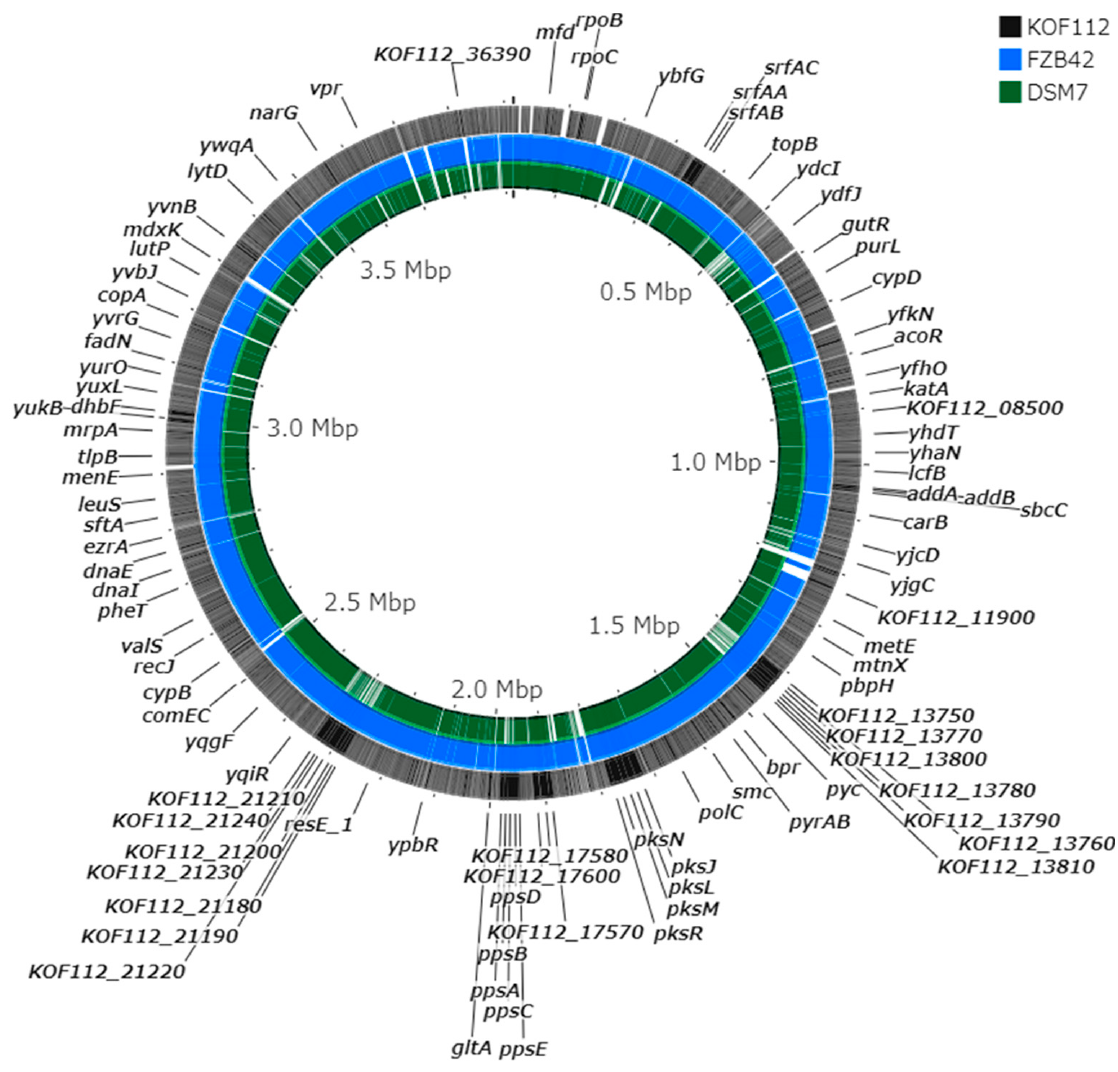
Figure 3. Genome comparison of KOF112, B. velezensis FZB42, and B. amyloliquefaciens DSM7. The whole genomes of KOF112 (outermost circle), FZB42 (middle circle), and DSM7 (innermost circle) were aligned using the CGView Server. The server used BLAST to compare the KOF112 genome sequence with FZB42 and DSM7 genome sequences. BLAST results and feature information for coding sequences were converted into a graphical map with black, blue, and green colors. Gene annotation of KOF112 coding sequences is partially shown in the figure.